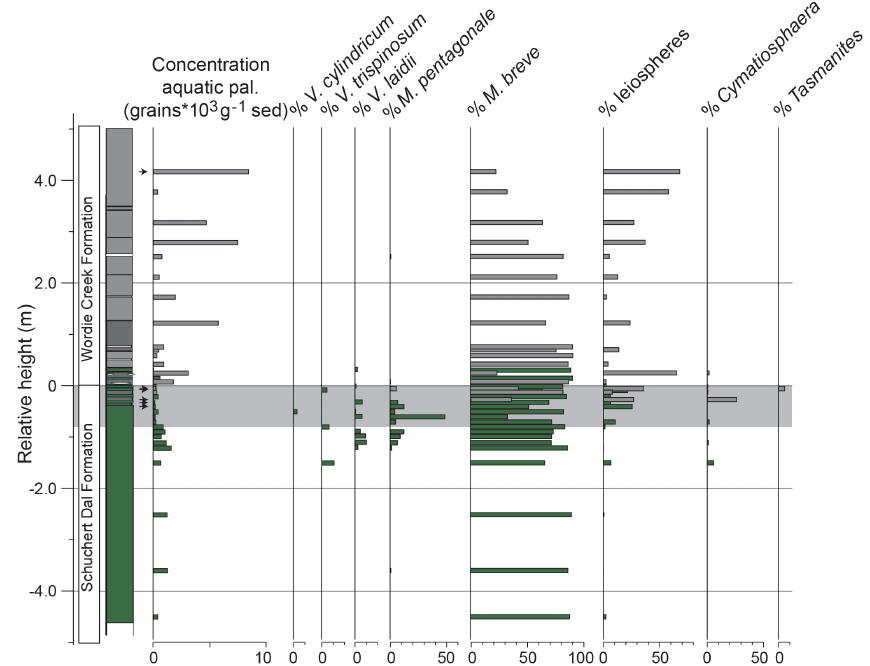
Figure 4. Concentrations of all aquatic palynomorphs and relative abundances of specific acritarch and prasinophyte groups. Arrows indicate intervals with low counts ( < 20). Green shading indicates data from bioturbated rocks; grey shading indicates data from laminated rocks. The grey horizontal bar indicates the extinction interval, based on high spore:pollen ratios.